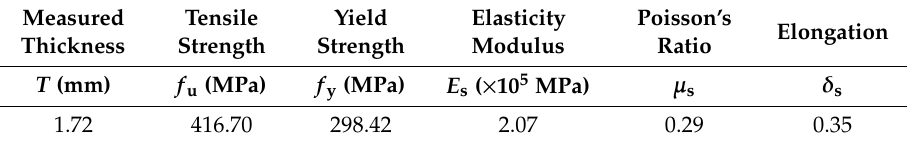
Table 3. Measured values of the steel material.